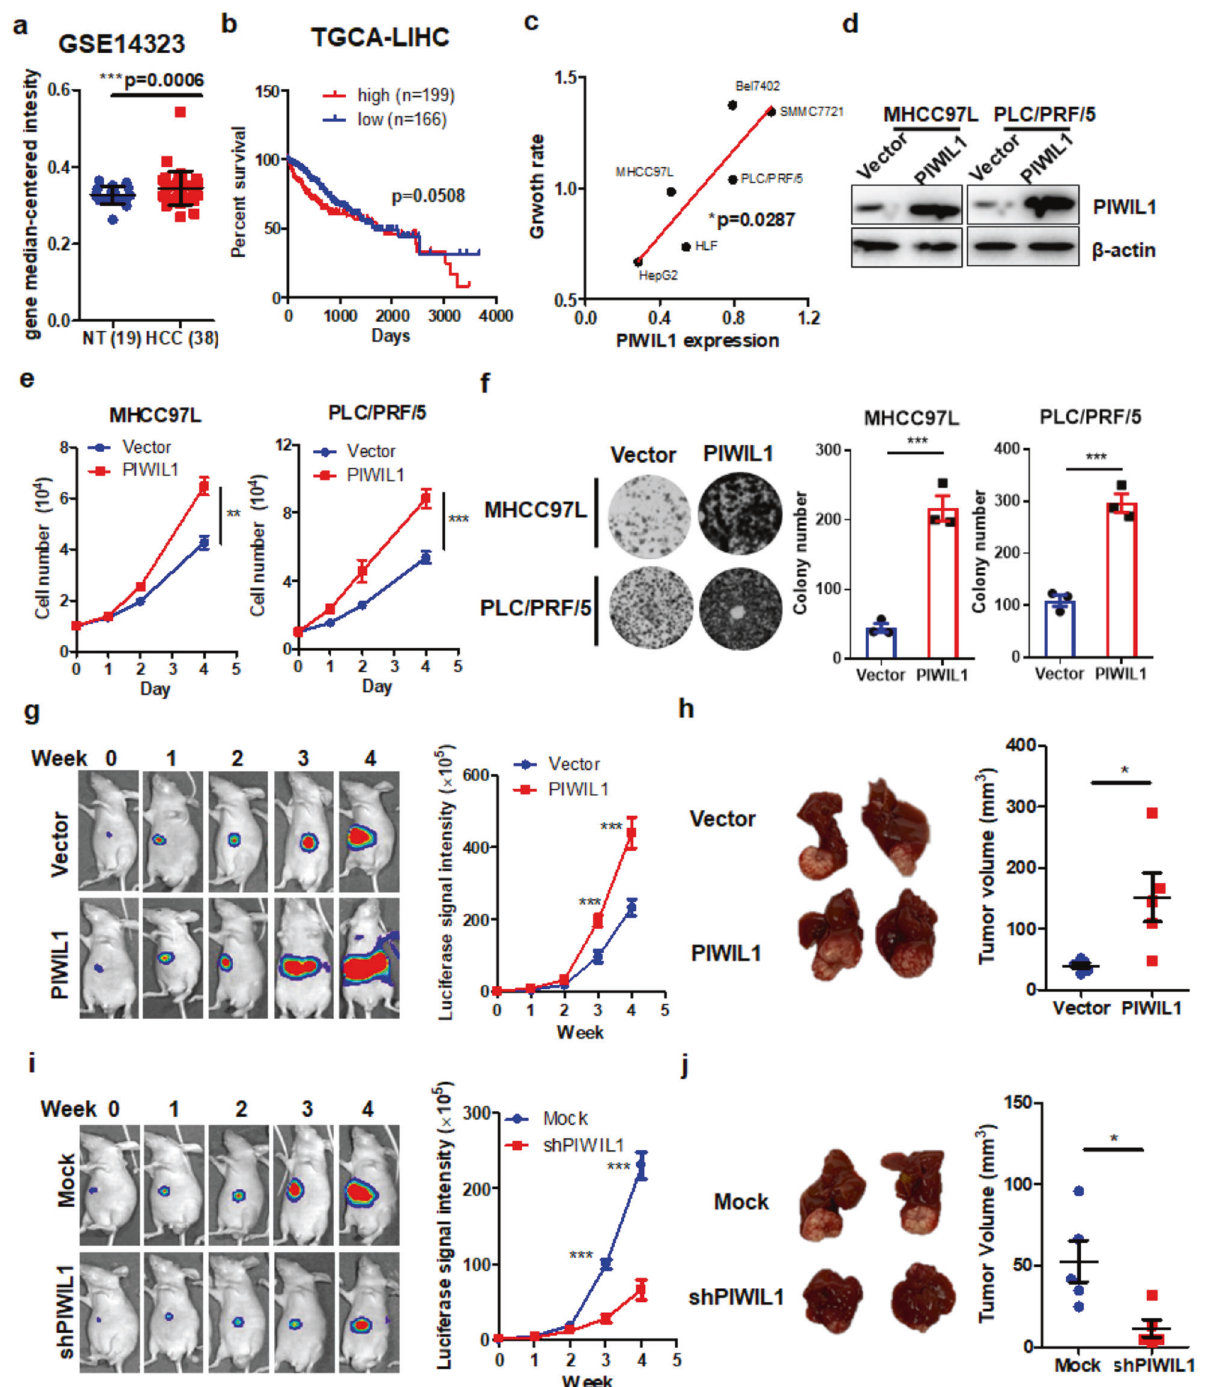
Fig. 1 PIWIL1 promotes in vitro proliferation and in vivo growth of HCC. a Data were retrieved from GEO dataset. The expression of PIWIL1 was signi fi cantly higher in HCC tissue than normal liver in both GSE14323 dataset; b the overall survival data of HCC patients were retrieved from the TCGA database ( n = 365). The expression of PIWIL1 has a weak correlation with the overall survival of HCC patients; c the mRNA expression of PIWIL1 in HepG2, MHCC97L, PLC/PRF/5, SMMC7721, Bel-7402, and HLF was measured by qRT-PCR. The cell proliferation rate was identi fi ed by calculating the value of the slope of the growth curve. The correlation was made and showed that the expression of PIWIL1 was positively correlated with the proliferation rate of the HCC cells; d Stable clones of PIWIL1-overexpressing MHCC97L and PLC/PRF/5 were established, and PIWIL1 overexpression was measured by immunoblotting; Overexpression of PIWIL1 could signi fi cantly promote the e proliferation and f colony formation of HCC cells. The orthotopic HCC model of mice was established with MHCC97L cells with or without PIWIL1 overexpression; g Overexpression of PIWIL1 could signi fi cantly intensify the luciferase signal intensity of MHCC97L cells, suggesting the weekly growth rate of orthotopic tumors was increased; h at the end of the study, the liver was dissected out. Tumors of HCC cells with PIWIL1 overexpression had a signi fi cantly larger size than those of wild-type cells ( n = 5). Knockdown of PIWIL1 could reduce i the orthotopic growth and j size of HCC tumor in the liver of mice ( n = 5). All experiments were performed in triplicate if without particular notice. * p < 0.05; ** p < 0.01; *** p < 0.001 Signal Transduction and Targeted Therapy (2021)